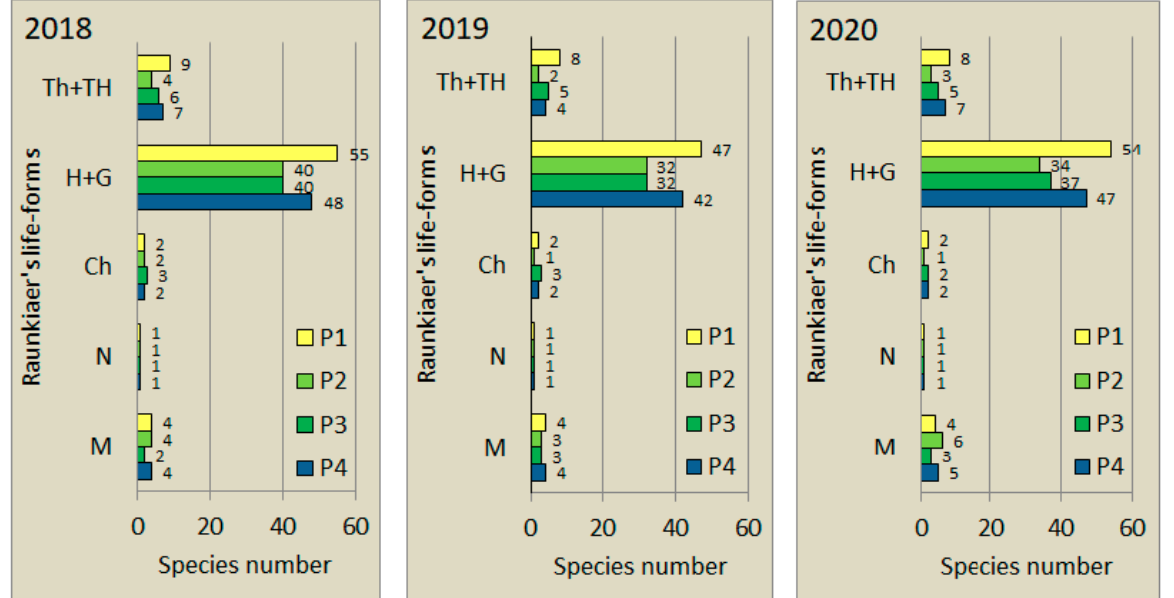
Figure 1. Life-form spectra of species in the four plots (P1–P4) of “P ó calja” Natura 2000 loess grassland (Central Hungary), in years 2018, 2019 and 2020. Th = therophytes, TH = hemitherophytes, H = hemicryptophytes, G = geophytes, Ch = chamaephytes, N = nanophanerophytes, M = phanerophytes.